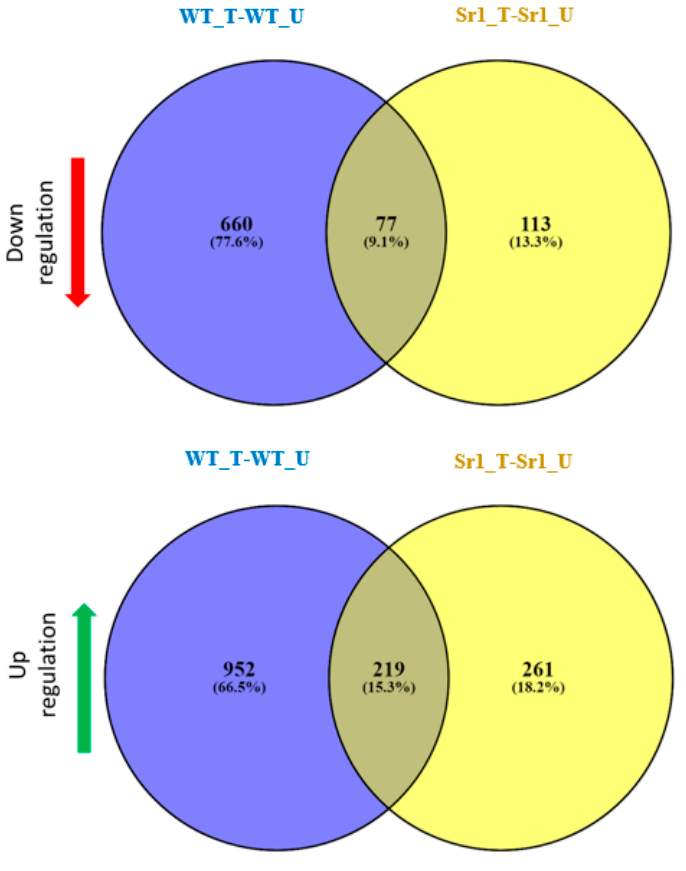
Figure 3. Comparative transcriptome analysis of WT and atsr1 . Venn diagram of a double-sided comparison of microarray expression data revealing the circles that represent total number and arrows that represent the number of differentially expressed genes (DEGs) between the genotype test or pathogen inoculation. 77 genes were observed to be down-regulated with a FC ≤ − 2 and p -value < 0.05. 219 genes were observed that are up-regulated with a FC ≥ 2 and p -value < 0.05. WT_U: WT untreated; WT_T: WT treated with pathogen infection for 24 h after infiltration with Pst DC3000; sr1_U: sr1 untreated; sr1_T: sr1 treated with pathogen infection for 24 h after infiltration with Pst DC3000.